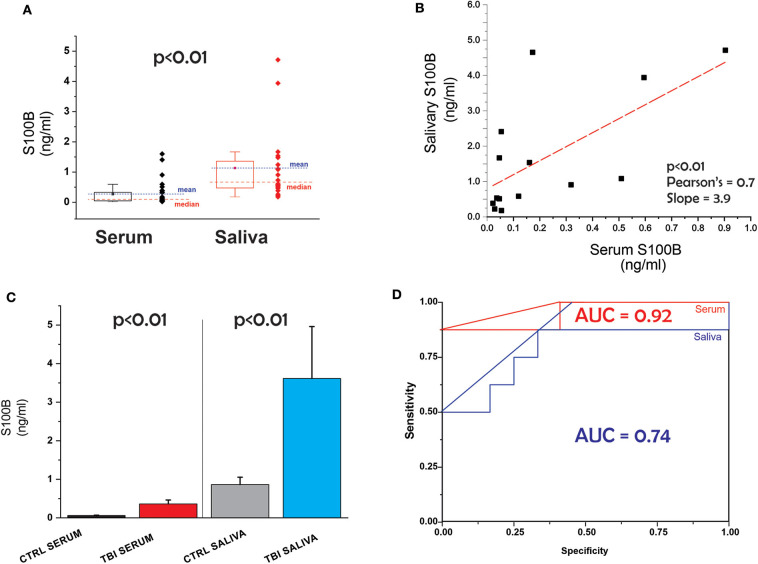
(A) Serum and salivary levels of S100B in all subjects. Red and blue symbols differentiate between control and TBI. (B) Correlation between salivary and serum S100B. (C) Comparable predictive value for TBI of saliva and serum; (D) ROC curves for salivary and serum S100B.